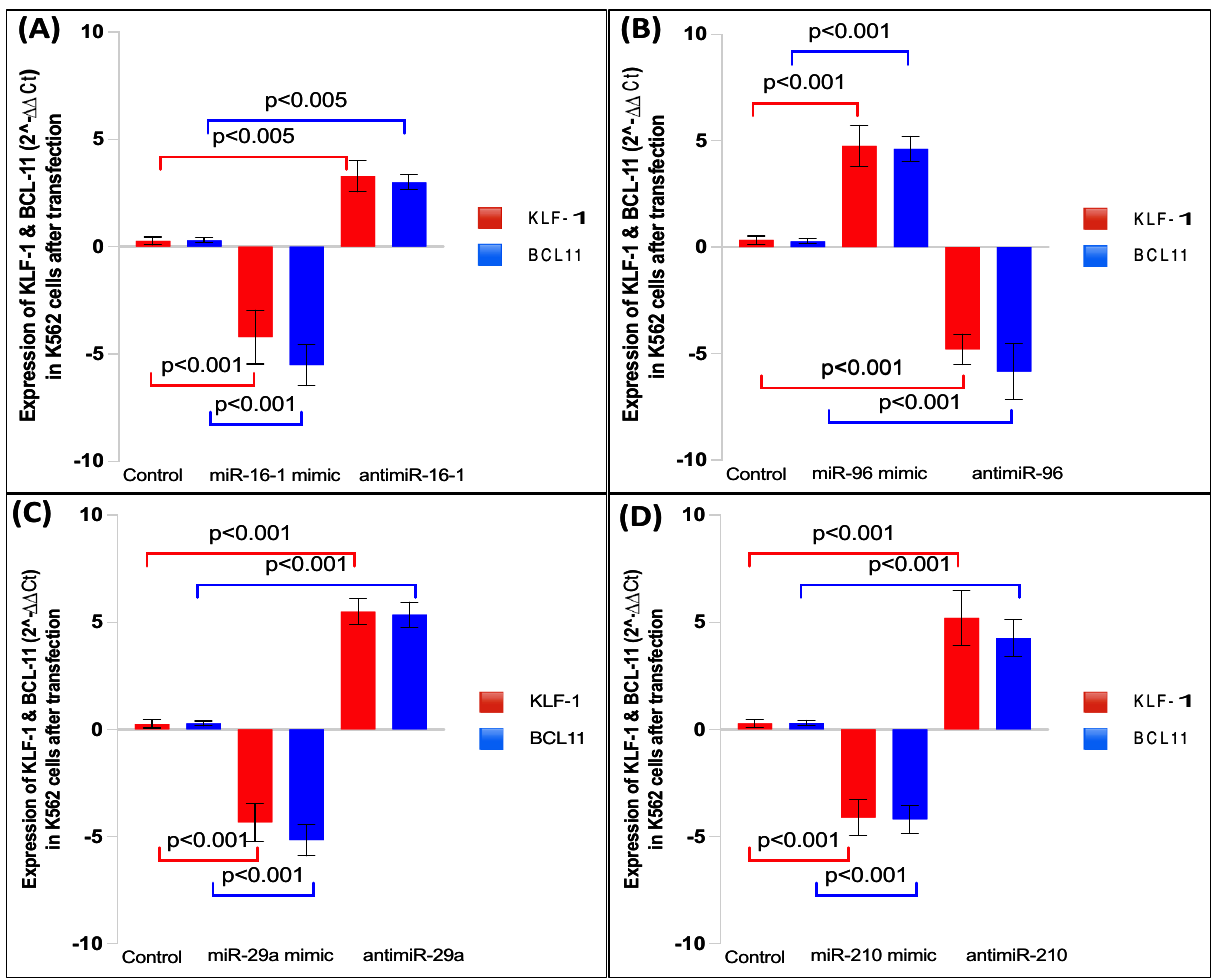
Figure 5. ( A ) Expression of KLF-1 and BCL11A after transfection of miR-16-1 mimic and antagomir in K562 cells. ( B ) Expression of KLF-1 and BCL11A after transfection of miR-96 mimic and antagomir in K562 cells. ( C ) Expression of KLF-1 and BCL11A after transfection of miR-29a mimic and antagomir in K562 cells. ( D ) Expression of KLF-1 and BCL11A after transfection of miR-210 mimic and antagomir in K562